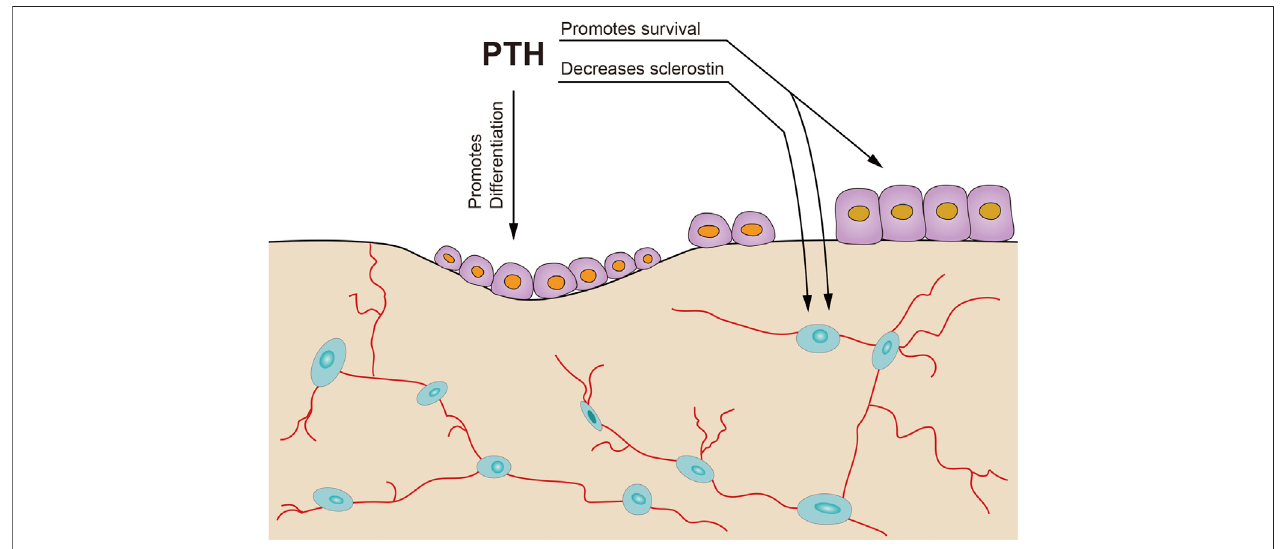
FIGURE 3 | Possible mechanisms of PTH anabolic action without prior osteoclast resorption. PTH could inhibit sclerostin production by osteocytes, promote survival of osteocytes and osteoblasts, and accelerate osteoblast differentiation in partly fi lled basic multicellular units [adapted from (Martin, 2014)].